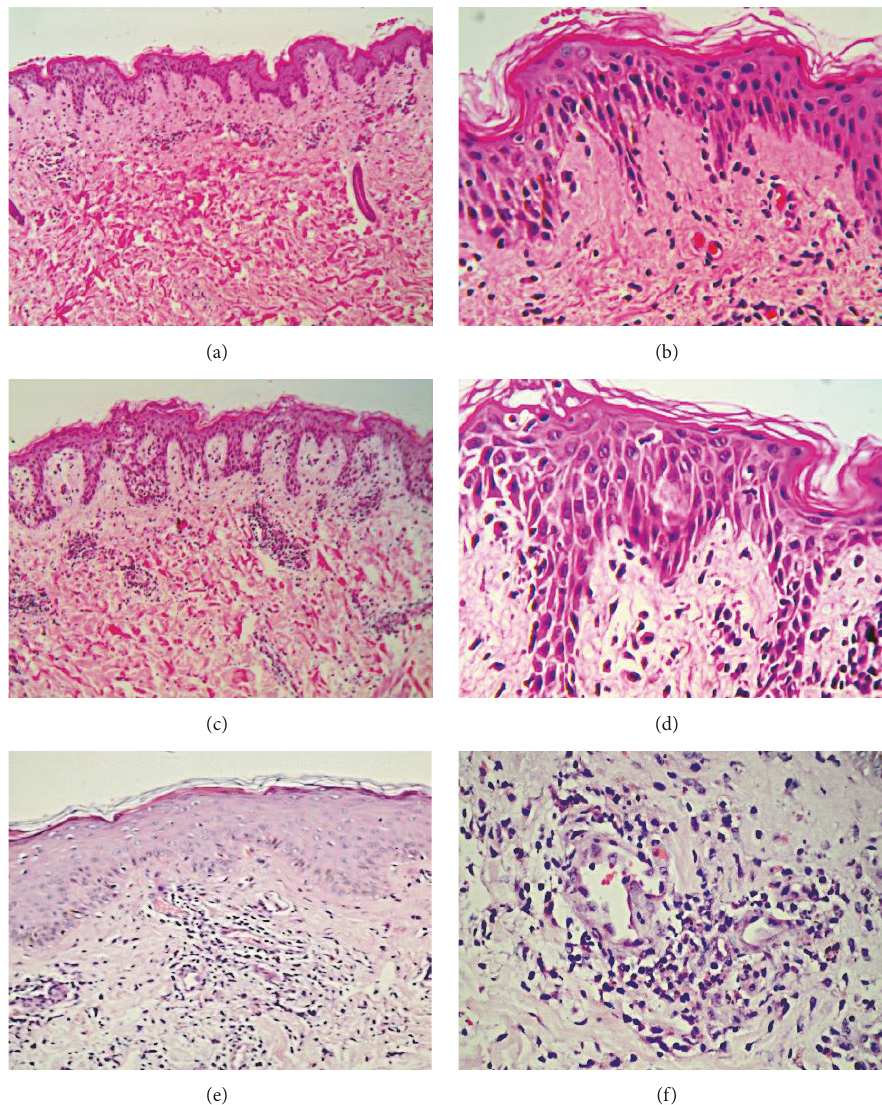
Figure2: Histopathologicalfeaturesofprurigopigmentosa. Biopsiestakenshowedevidenceofmildhyperkeratosis,acanthosis,spongiosis, and mild superficial perivascular inflammatory cell infiltrate on low power in patient 1, patient 2, and patient 3 (a, c, and e, resp.), as well as dyskeratosis and hydropic degeneration of the basal cell layer, papillary dermal oedema, and superficial perivascular lymphoid cell infiltrate containing neutrophils and nuclear dust on high power. High power showed additional features of dyskeratotic hydropic degeneration of the basal cell layer, papillary dermal oedema, and superficial perivascular lymphoid cell infiltrate containing neutrophils and nuclear dust in patient 1, patient 2, and patient 3 (b, d, and f,